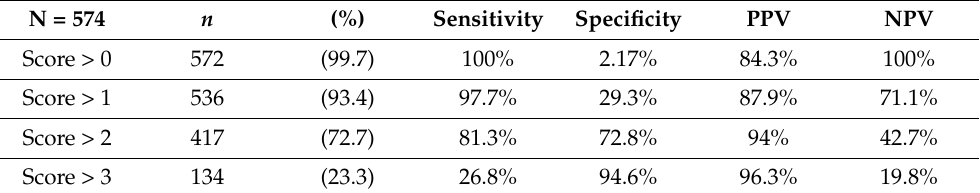
Table 7. Screening test indices for each score.